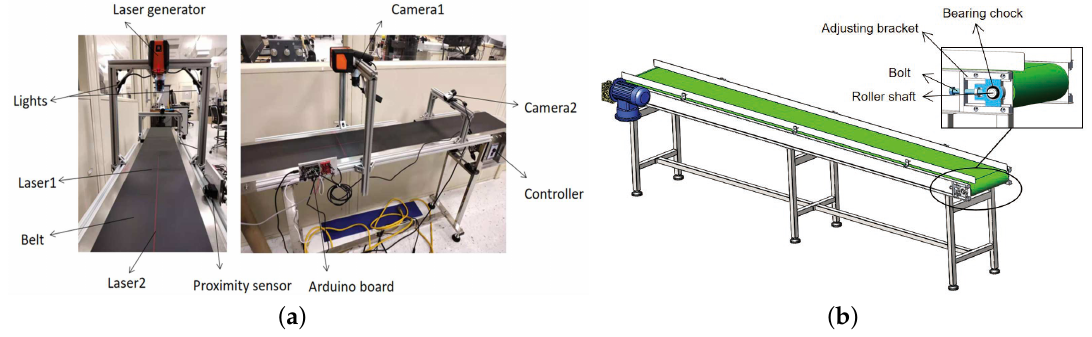
Figure 1. Experimental setup: ( a ) actual experimental setup, ( b ) structure model of conveyor tail